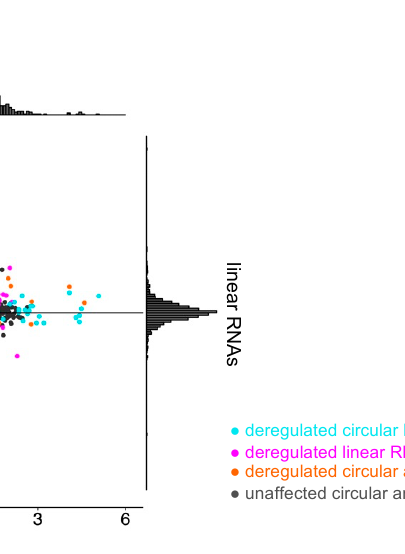
Figure 2. Cont (b) Host genes of downregulated circRNAs